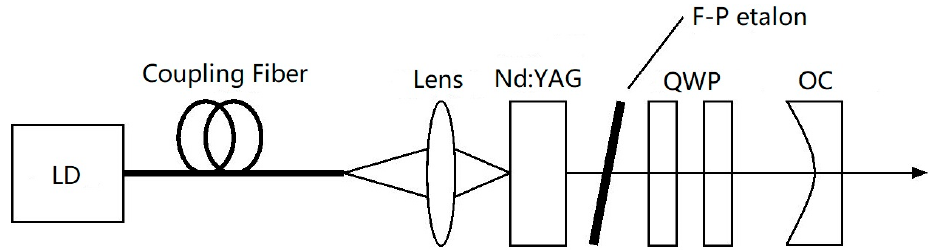
Figure 4. Schematic diagram of dual-frequency Nd:YAG laser [21]. LD: laser diode; F-P etalon: Fabry–Perot etalon; QWP: quarter-wave plate; OC: output coupler.